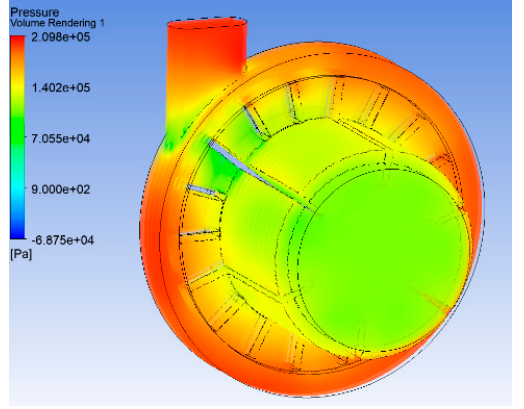
Figure 6. Pressure schedules of the pumped liquid for simulation 5.